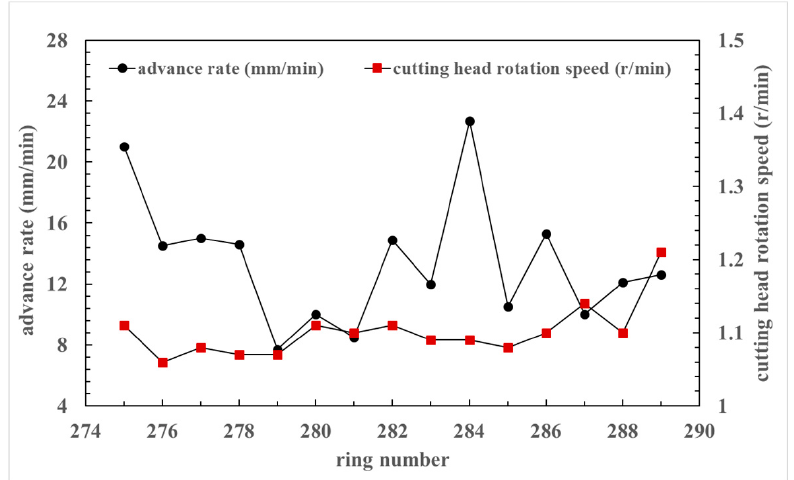
Figure 16. Changes of advance rate and cutting head rotation speed of the machine at the Wuhan Metro Line 8 Yangtze River Crossing tunnel construction.